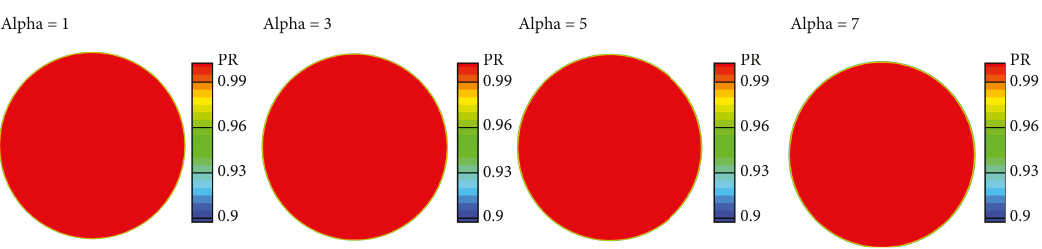
Figure 24: The inlet distortion of the BWB300 at di ff erent attack angles (high speed).